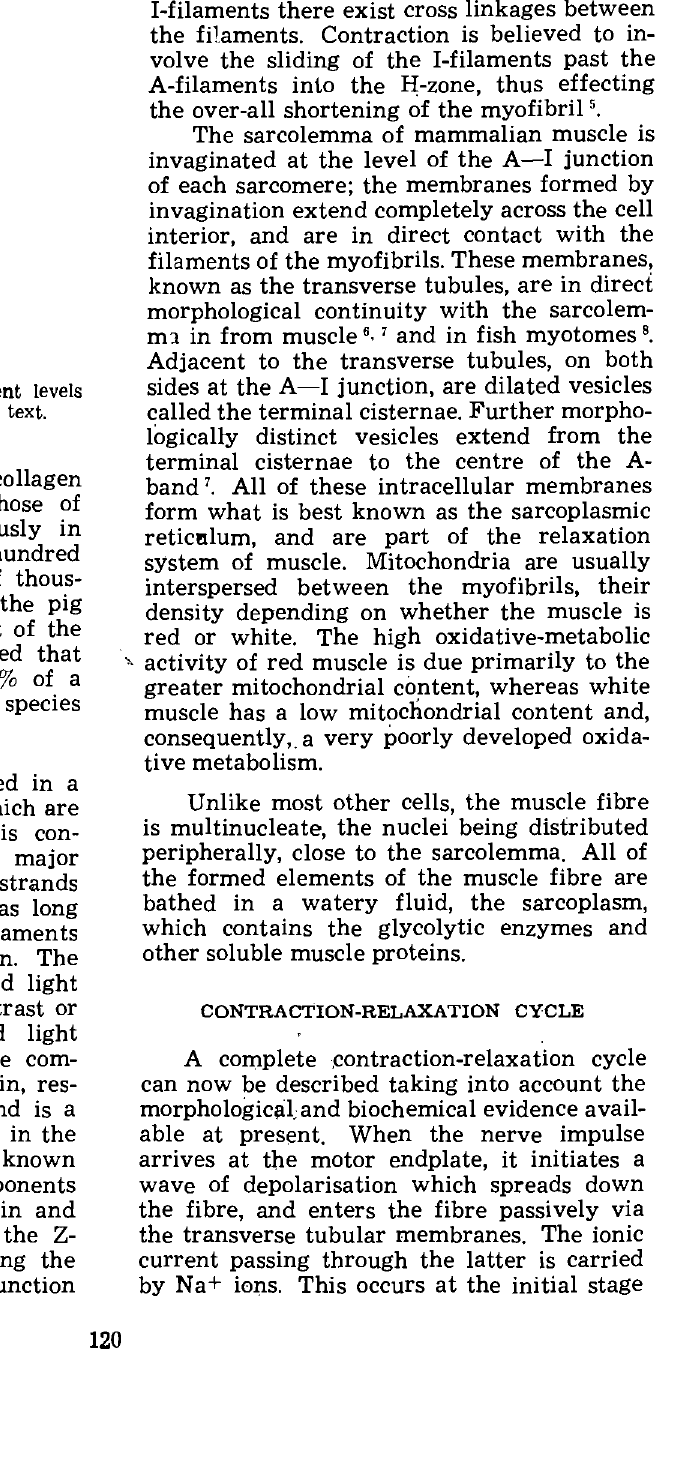
Fig. 1: The skeletal muscle fibre at different levels of structural organization. described in the text. most connective tissue sheath, the collagen fibrils of which anastomose with those of the